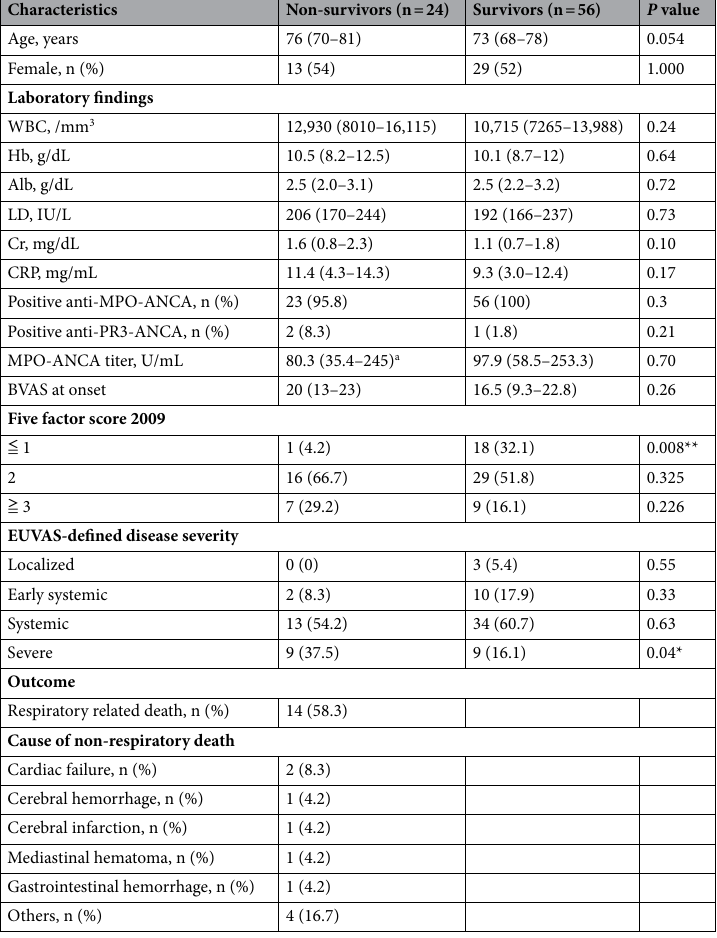
Table 1. Comparison of clinical characteristics, and outcomes between non-survivors and survivors in MPA patients. The laboratory markers are presented as the median (interquartile range). The P-values